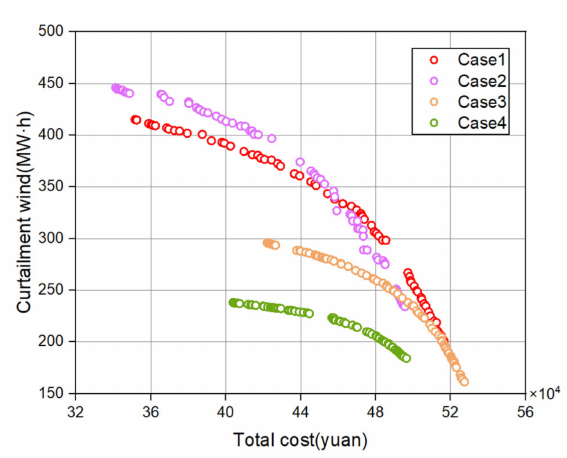
Figure 10. Pareto solution set distribution in different cases.